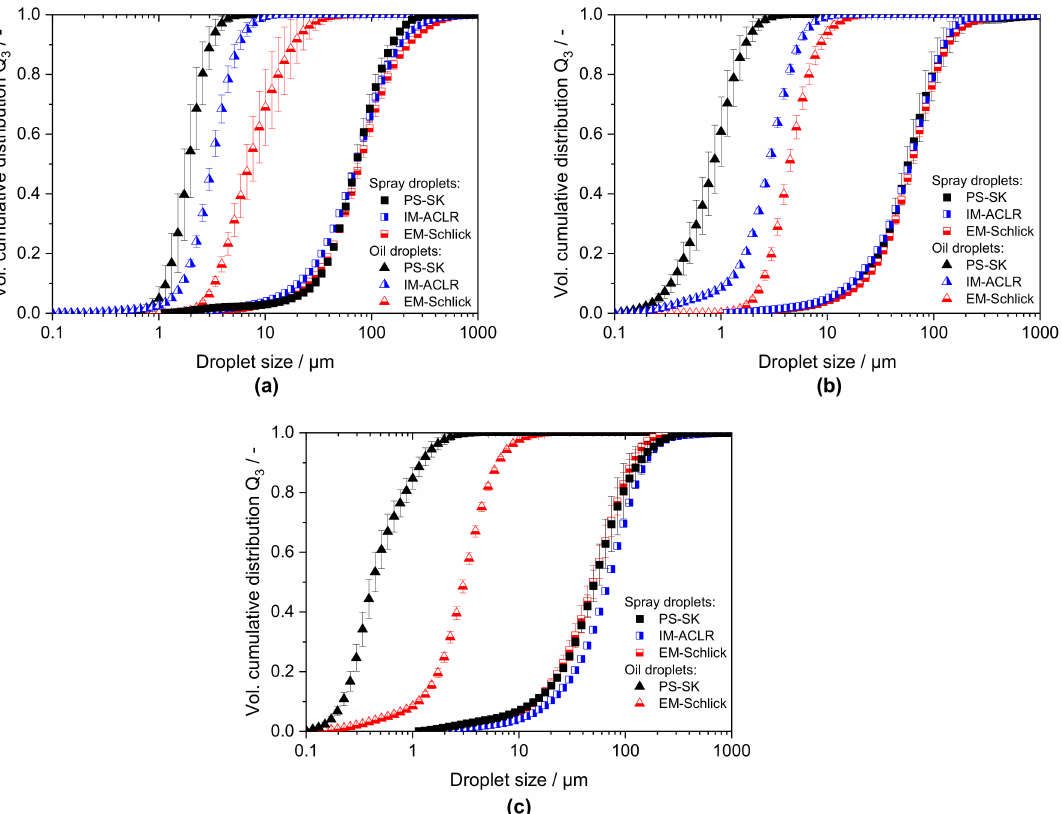
Figure 2. Spray droplet size distribution and resulting oil droplet size distributions in emulsions after atomization with a pressure swirl atomizer (PS-SK), an internal mixing (IM-ACLR) and an external mixing (EM-Schlick) twin-fluid atomizer for a liquid volume flow rate of: ( a ) 21.8 L/h; ( b ) 28 L/h; ( c ) 33.3